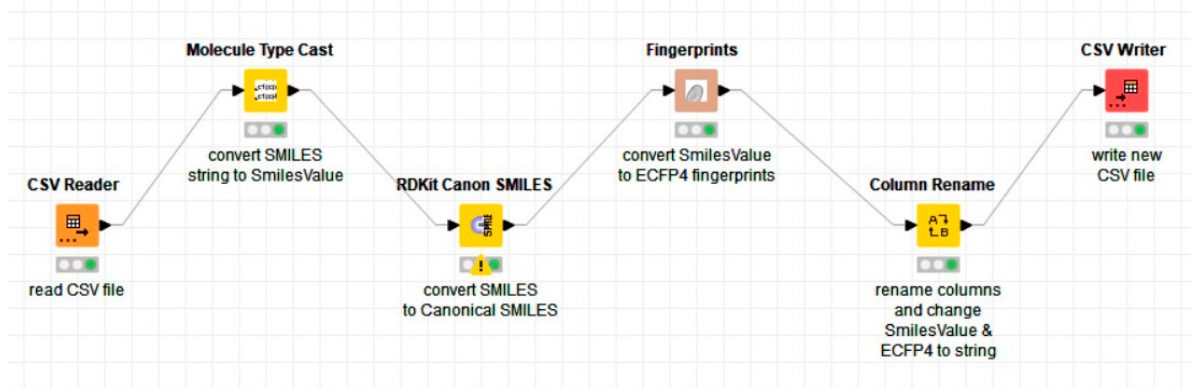
Figure 5. The workflow developed to convert the SMILES notation to canonical SMILES using the RDKit extension and then into chemical fingerprints (ECFP4) using the CDK extension in KNIME.